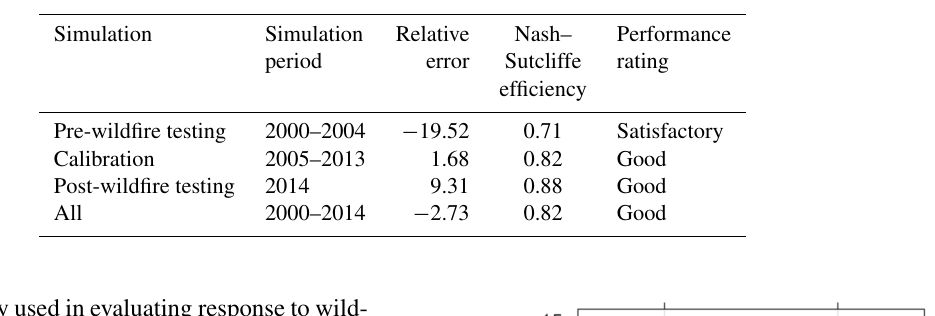
Table 2. Error statistics between observed and simulated daily streamflows for the calibration period as well as the testing periods. Perfor- mance ratings based on Motovilov et al. (1999).